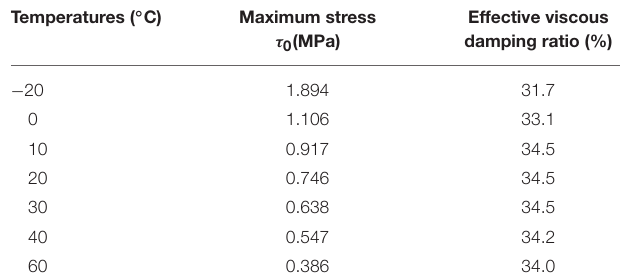
TABLE 2 | Mechanic parameters of the VE damping device under different temperatures.